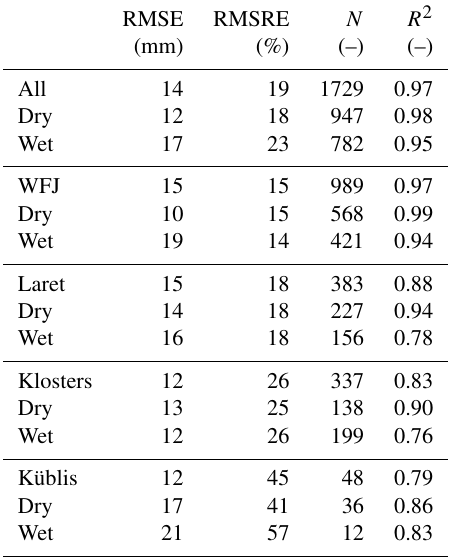
Table 4. Root mean square error (RMSE), root mean square rela- tive error (RMSRE), number of data points N and R 2 from linear regression for GNSS-derived HS compared to the data from the au- tomated sensors for all sites jointly and separately for the individual sites. Data points with HS < 10cm were excluded from the